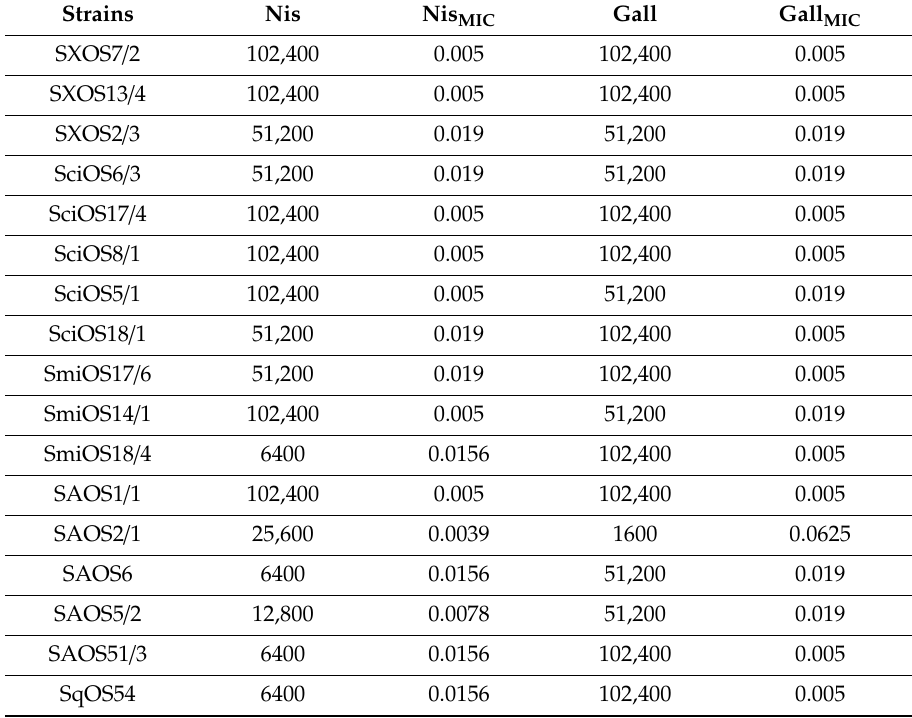
Table 4. Susceptibility of staphylococci to nisin and gallidermin, expressed in arbitrary unit per mL and in minimal inhibition concentration (MIC, µ